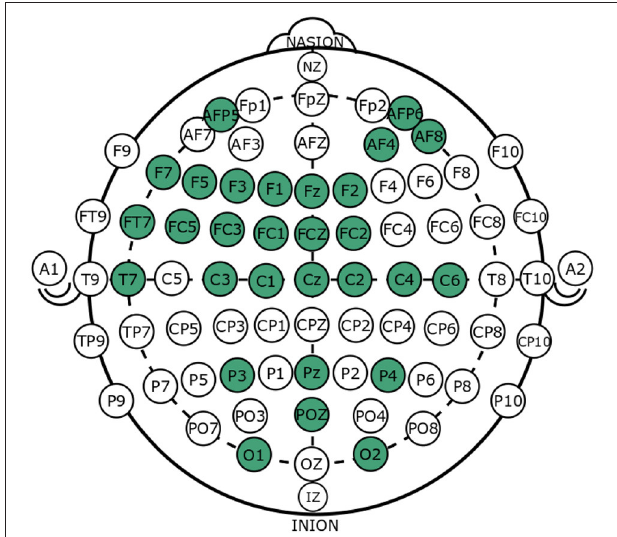
FIGURE 1 | Binary summary of neural correlates of trust in technology domain. All green locations have bee shown to vary by trust condition in at least one study (refer to Table 3